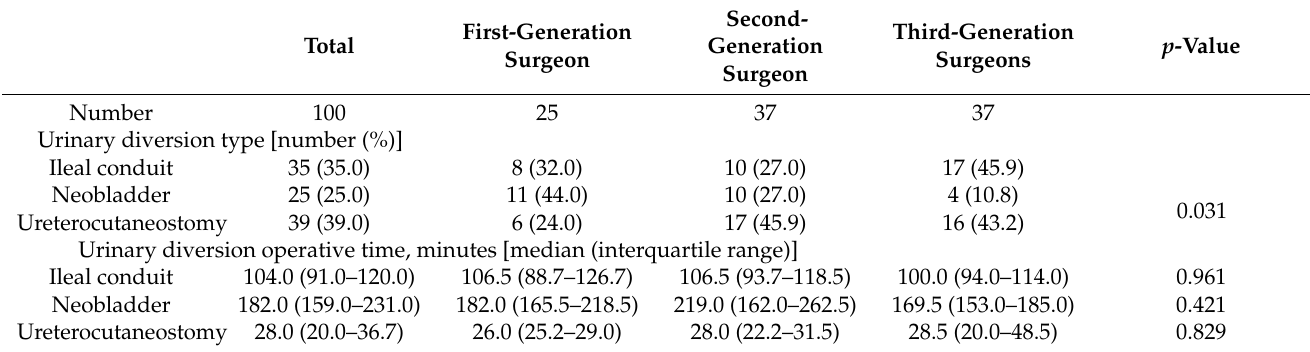
Table 3. Surgical outcomes according to the intracorporeal urinary